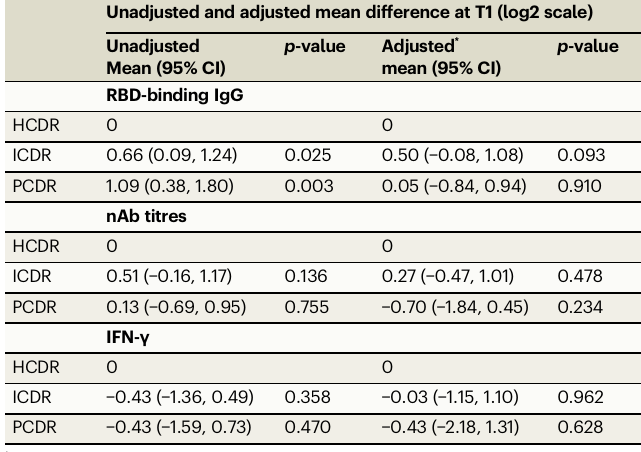
Table 3 | Adjusted mean differences from fi tting an ANCOVA model (contrasts between groups) Unadjusted and adjusted mean difference at T1 (log2 scale) Unadjusted Mean (95%